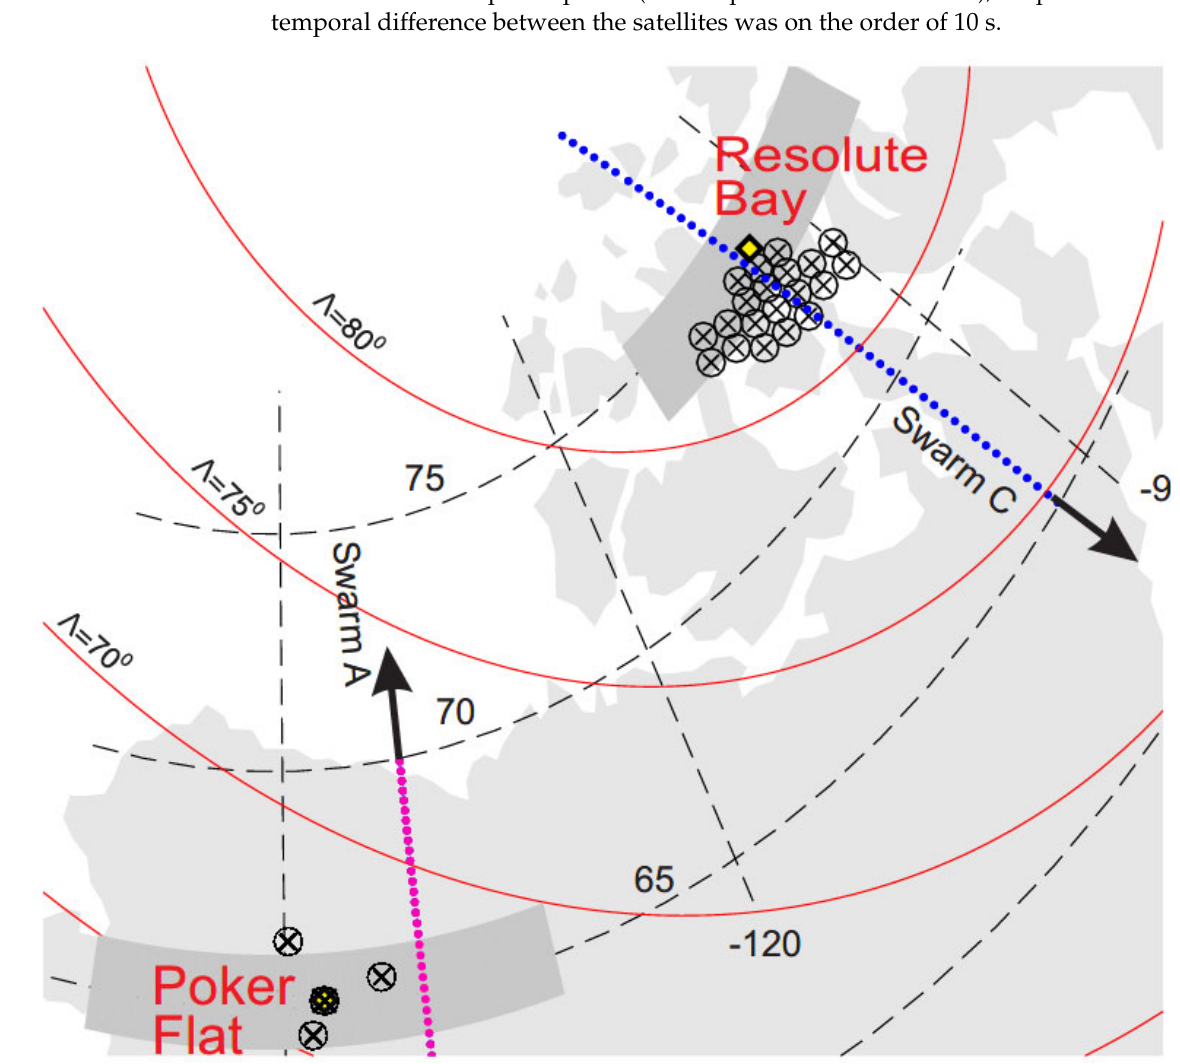
Figure 1. A map illustrating typical measurement coverage by RISR ‐ C (Resolute Bay) and PFISR (Poker Flat) and the footprints of the Swarm satellites passing the area of ISR measurements in two different events. For the ISRs, an altitude of ~450 km was considered. Crosses indicate those locations for which an averaged electron density was computed and compared to Swarm data. Darker shaded segments around RB and PF outline the areas over which Swarm data were averaged along a trajectory. Shown by solid dots are Swarm C footprints for 27 July 2016 (around 16:35 UT, blue) and Swarm A footprints for 21 February 2015 (around 07:23 UT, pink). Arrows indicate the directions travelled by the satellites.